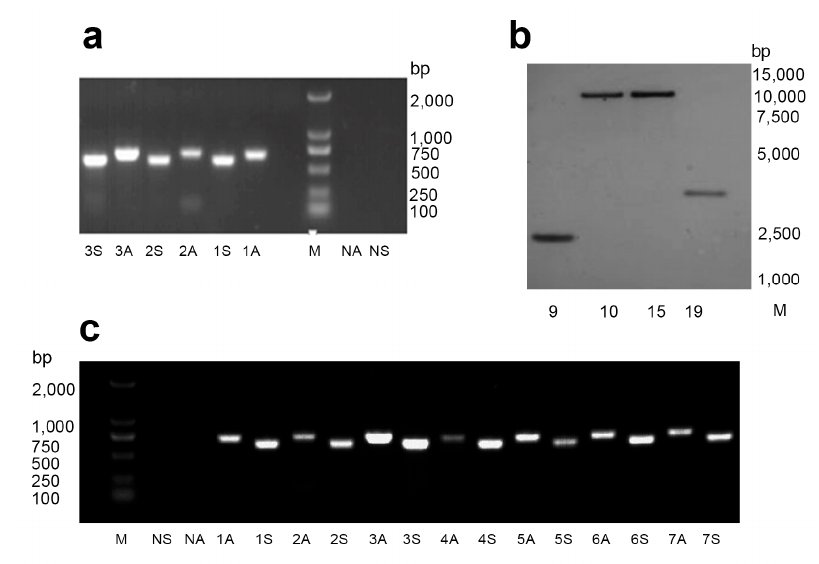
Figure 1. Molecular detection of transgenic cotton lines. ( a ) PCR analysis of cotton expressing HaHR3 with primers amplifying sense and anti-sense fragments. Lanes 1S–3S denote PCR analysis of lines 5, 7, and 9 with sense fragment primers. Lanes 1A–3A denote PCR analysis of lines 5, 7, and 9 with anti-sense primers. Lanes NA and NS are antisense and sense negative controls, respectively. M: DL2000 Marker; ( b ) southern blot analysis of transgenic cotton. 9, 10, 15, and 19 denote transgenic cotton lines. M: DL15000 Marker; ( c ) RT-PCR analysis of cotton expressing HaHR3 with primers amplifying sense and anti-sense fragments. Lanes 1S–7S denote PCR analysis of lines 5, 7, 8, 9, 10, 15, and 19 with sense fragment primers. Lanes 1A–7A denote PCR analysis of lines 5, 7, 8, 9, 10, 15, and 19 with anti-sense primers. Lanes NA and NS are antisense and sense negative controls, respectively. M: DL2000 Marker.